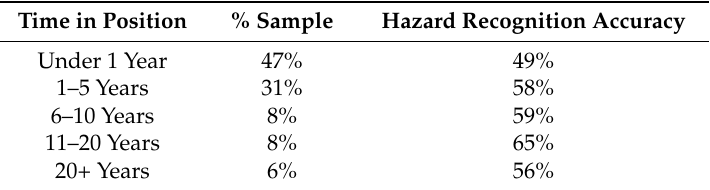
Table 1. Hazard recognition accuracy by time in current job